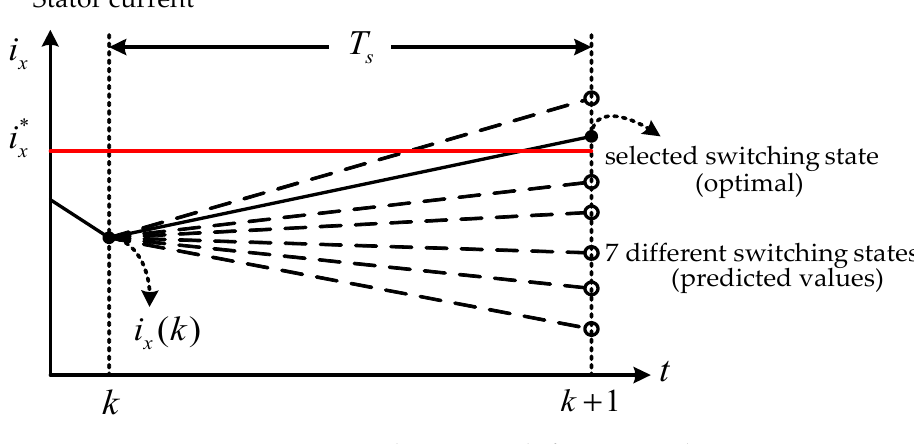
Figure 4b that two voltage vectors 𝑉 (cid:3046) (cid:3030)(cid:2869) and 𝑉 (cid:3046) (cid:3030)(cid:2870) are applied successively for current prediction in a sampling period, with durations 𝑇 (cid:3038)(cid:3030)(cid:2869) and 𝑇 (cid:3038)(cid:3030)(cid:2870) , respectively. One gains apparent benefits by using two modulated voltage vectors whose application durations are adapted and optimized online. This